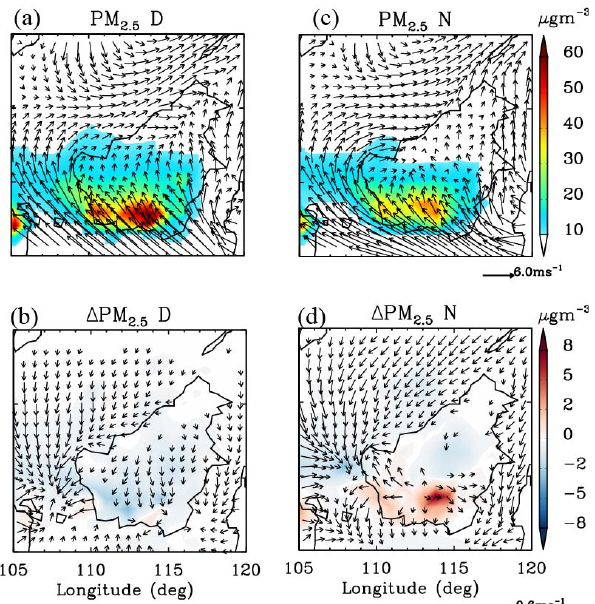
Fig. 5. Distribution of monthly averaged variables in October 2006. Anomaly of surface wind and monthly averages of surface PM 2 . 5 respectively at (a) daytime and (c) nighttime. Difference of surface wind anomaly and surface PM 2 . 5 in monthly averages due to smoke radiative effect at (b) daytime and (d) nighttime. The anomaly of surface wind is the difference between the wind at certain local time and the wind of monthly mean. The OC/BC ratio is 10 in the sim- ulation.